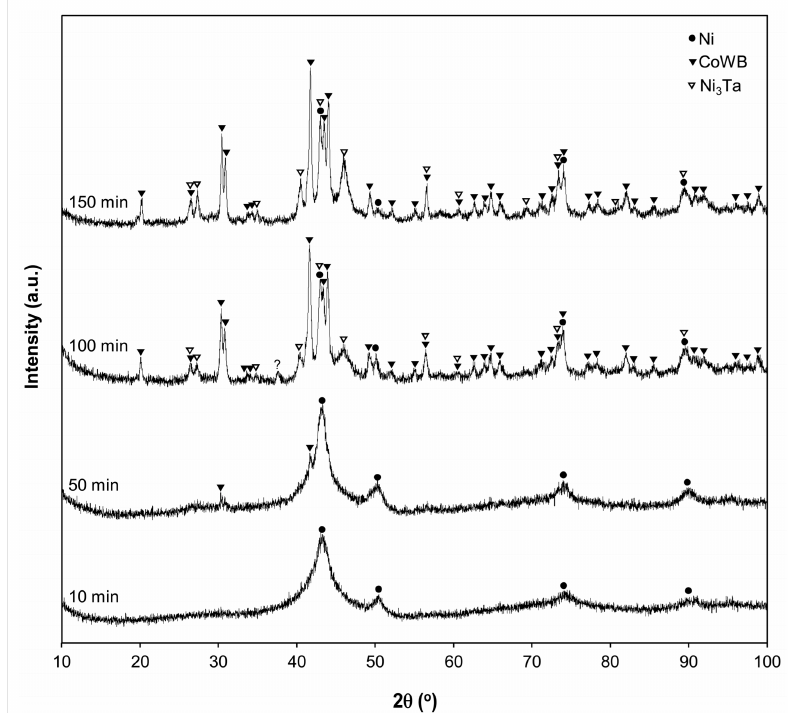
Figure 2. XRD patterns of the samples annealed at 1025